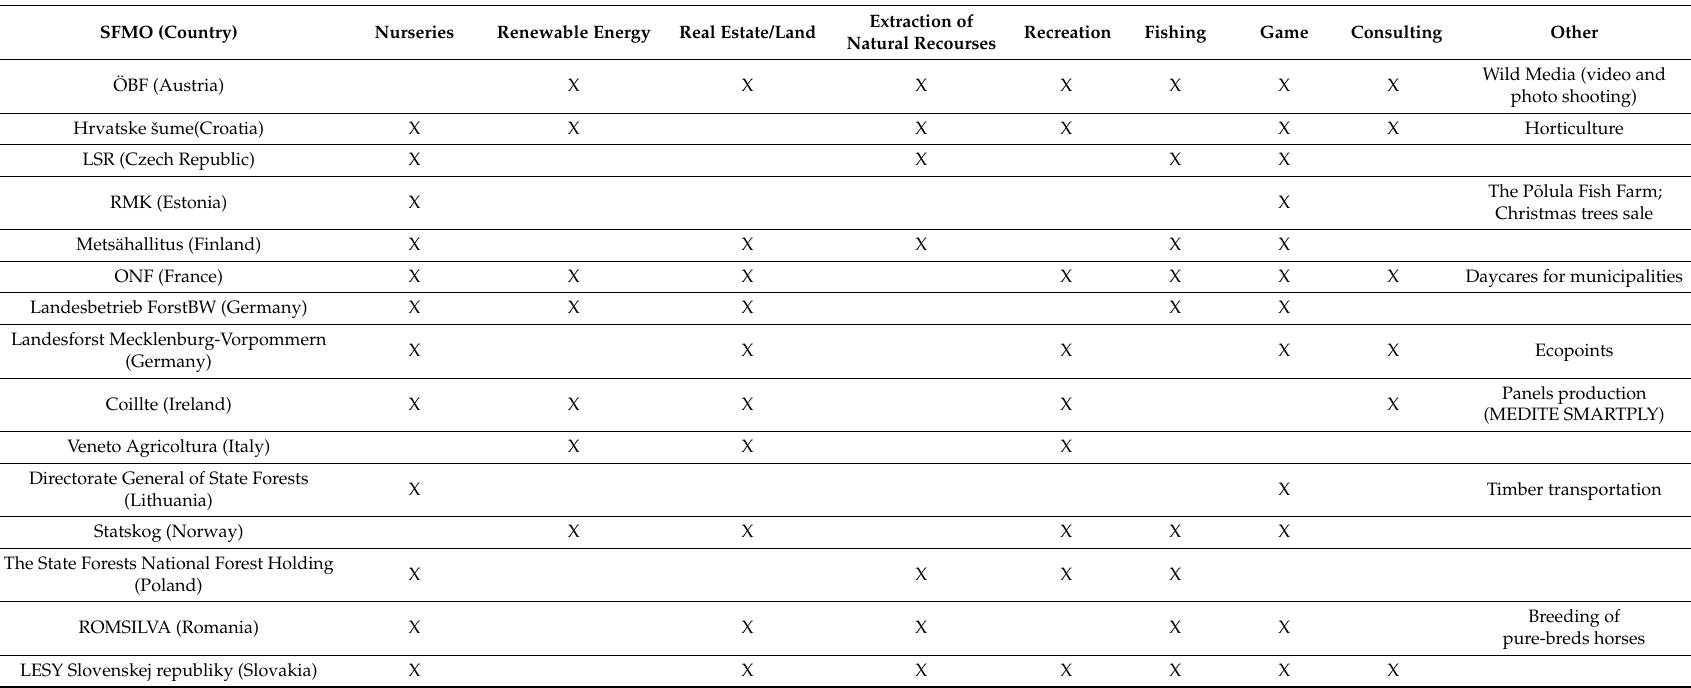
Table 5. Non-wood business activities of SFMOs (own